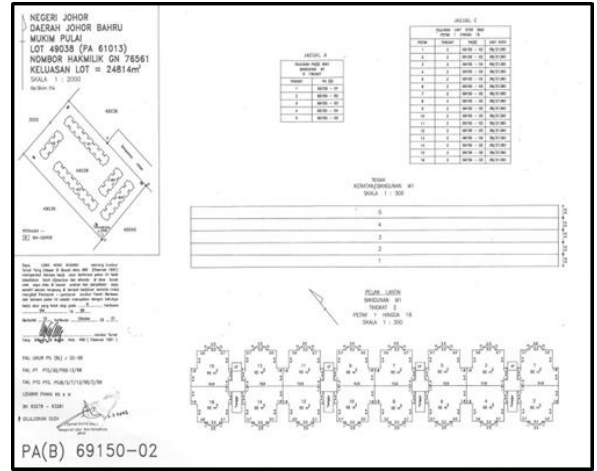
Figure 1. Certified plan provided by